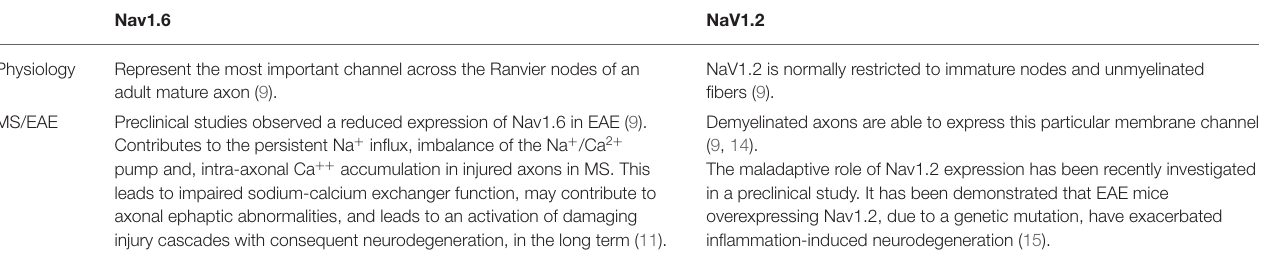
TABLE 1 | Multiple sodium channel isoforms are expressed in different tissues and initiate action potentials in neurons, skeletal muscles, and cardiac muscles. Nav1.6 NaV1.2 Represent the most important channel across the Ranvier nodes of an adult mature axon (9).